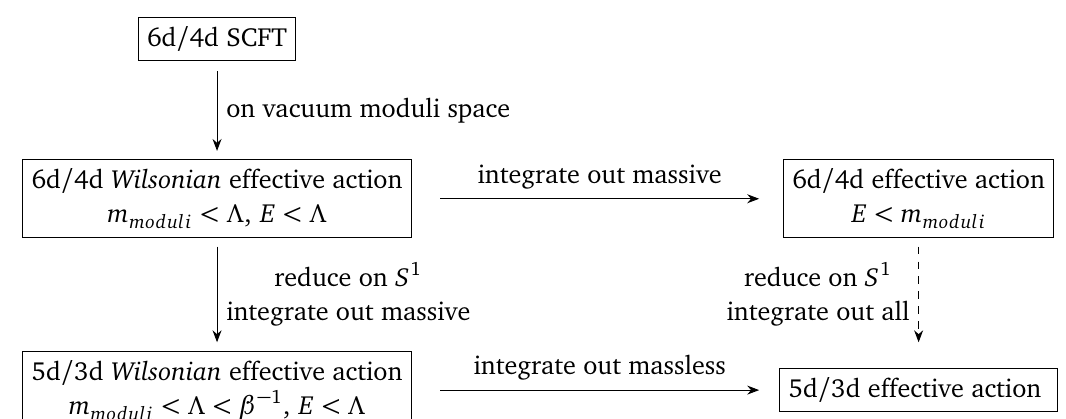
Figure 1: Diagram depicting the relations among different effective actions. We de- note by Λ the cutoff of the effective action, and m is the mass scale associated moduli with the moduli scalar vacuum expectation value. The field contents are as follows: the Wilsonian effective action contains light dynamical fields and background fields; the 6d / 4d effective action contains massless dynamical fields and background fields; the 5d / 3d effective action contains only background fields. On the one hand, the ↓→ direction is in principle correct but difficult to carry out (unless the effective theory is weakly coupled). On the other hand, except on the pure Higgs branch, where the Green-Schwarz / Wess-Zumino type terms relevant for (mixed) gravitational anoma- lies are absent in the 6d / 4d effective action, it is not understood how to perform the dashed arrow on the right. This is the source of the puzzle of Section